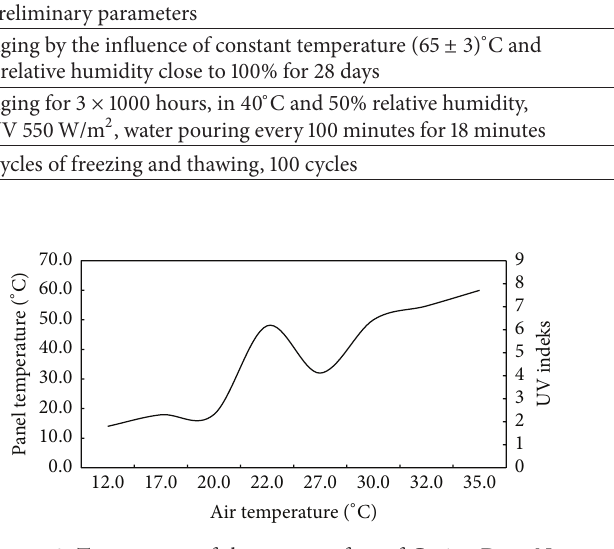
Figure 3: Temperature of the outer surface of Corian Deep Noc- turne (PMMA/ATH) black facade panels mounted on the southern wall, read between 27.07.13 and 20.09.13 in